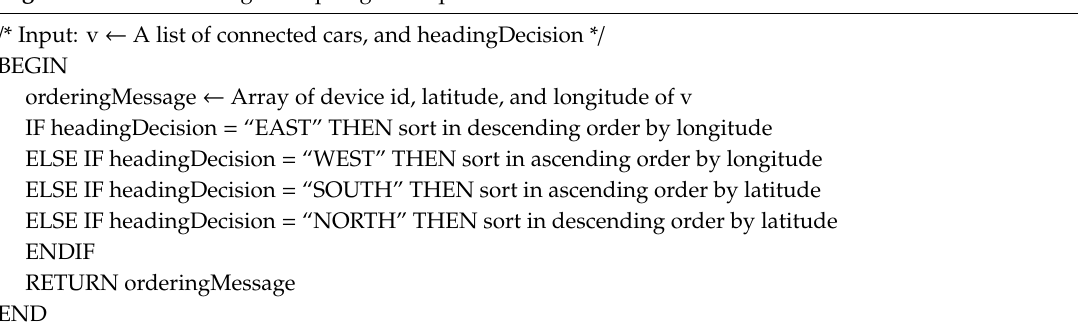
Algorithm 3 Determining the topological sequence of connected